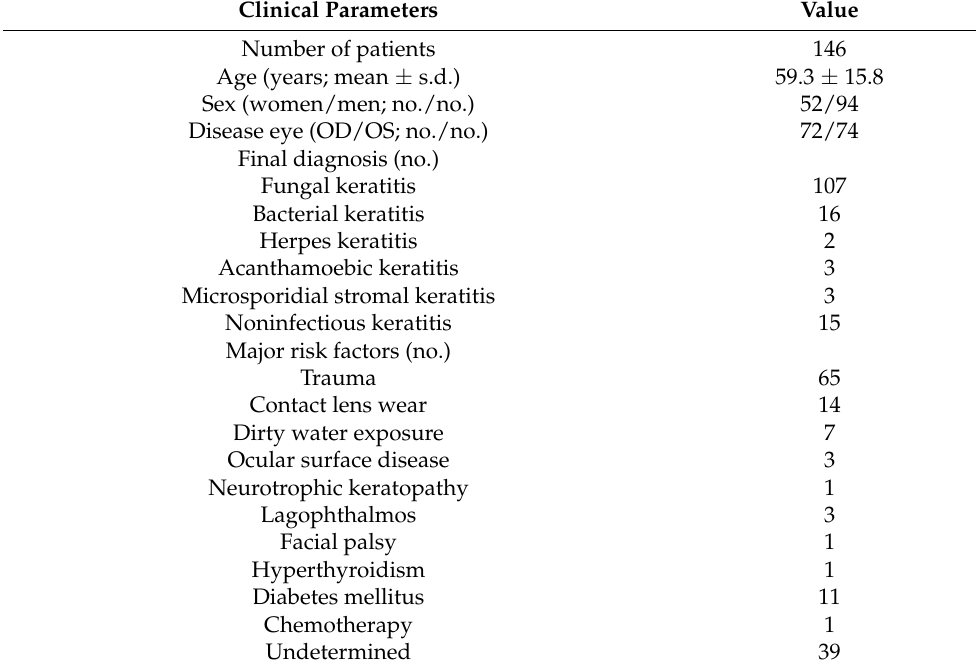
Table 3. Demographic data of subjects.